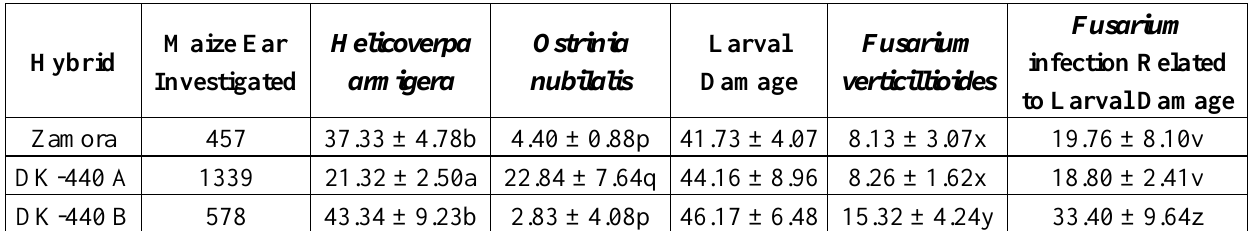
Table 2. Percentage infestation rates by Helicoverpa armigera , Ostrinia nubilalis and Fusarium verticillioides on maize ears at three different plots at Julianna-major * .